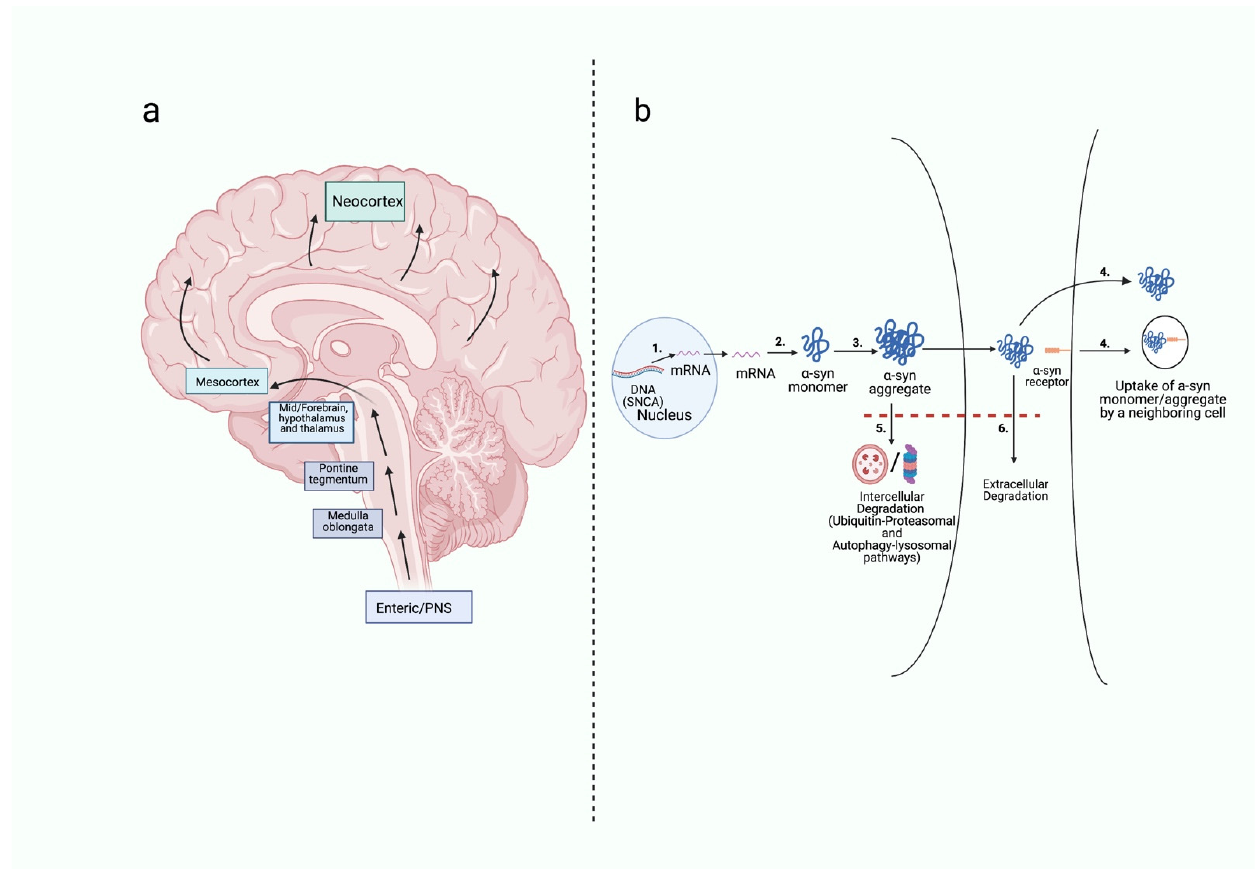
Figure 1. The neuroanatomy of alpha-synuclein aggregation pathology propagation from the enteric nervous system, and the cellular mechanism of this propagation. ( a ) The neuroanatomical propagation of alpha-synuclein throughout the brain is currently best described by the Braak hypothesis. The spread of alpha-synuclein occurs in a caudo-rostral manner, with initial pathological aggregation occurring in the enteric nervous system. Braak stage 1 is characterized by alpha-synuclein accumulation in early brain areas, including the dorsal motor nucleus of the vagus nerve (medulla oblongata) and the olfactory bulb. Braak stage 2 is associated with the involvement of the raphe nuclei and medullary reticular formations (medulla oblongata) and the pontine tegmentum. Braak stage 3 involves alpha-synuclein aggregation in the substantia nigra pars compacta (SNpc) and basal forebrain areas. Braak stage 4 is defined by the neurodegeneration of the SNpc and aggregation observed in the mesocortex (e.g., amygdala). At Braak stage 5, alpha-synuclein pathology can begin to be identified in neocortical areas (e.g., frontal, parietal, and temporal lobes). Finally, Braak stage 6 relates to the most ad- vanced stage of disease progression, with widespread neurodegeneration and widespread neocortical alpha-synuclein accumulation [8]. ( b ) The cellular propagation of alpha-synuclein occurs in a prion-like manner of transmission. The spread of pathological alpha-synuclein in the enteric, peripheral, and central nervous systems is dependent upon six key components, depicted in the above figure: gene transcription (1), alpha-synuclein translation (2), alpha-synuclein aggre- gation (3), and alpha-synuclein uptake into the neighboring neurons (4), as well as insufficient intracellular (5) and extra- cellular (6) degradation. This figure was created with BioRender.com.